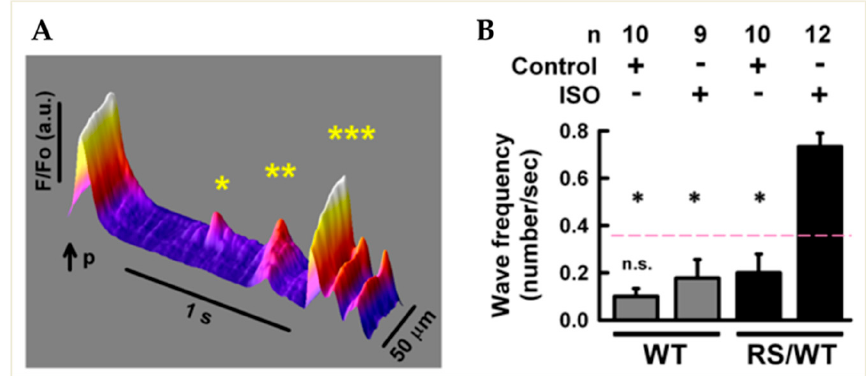
Figure 1. Spontaneous Ca 2+ release in adult cardiomyocytes isolated from CPVT mouse hearts. ( A ) Fluorescence image of Ca 2+ dynamics monitored with confocal microscopy in a heterozygous RyR2 RS/wt (RS/WT) CM during isoproterenol (ISO, 1 μ M) stimulation. Upon steady-state pacing, the last depolarization pulse (p) activates a regular intracellular Ca 2+ transient, followed by abnormal spontaneous (un-paced) Ca 2+ waves: * localized; ** cell-wide; *** regenerative. F/Fo, normalized fluorescence Ca 2+ signal intensity. ( B ) Bar graph summarizing cell-wide Ca 2+ wave occurrence in WT and CPVT CMs in basal conditions vs. ISO stimulation. Error bars represent SD; * p < 0.05.